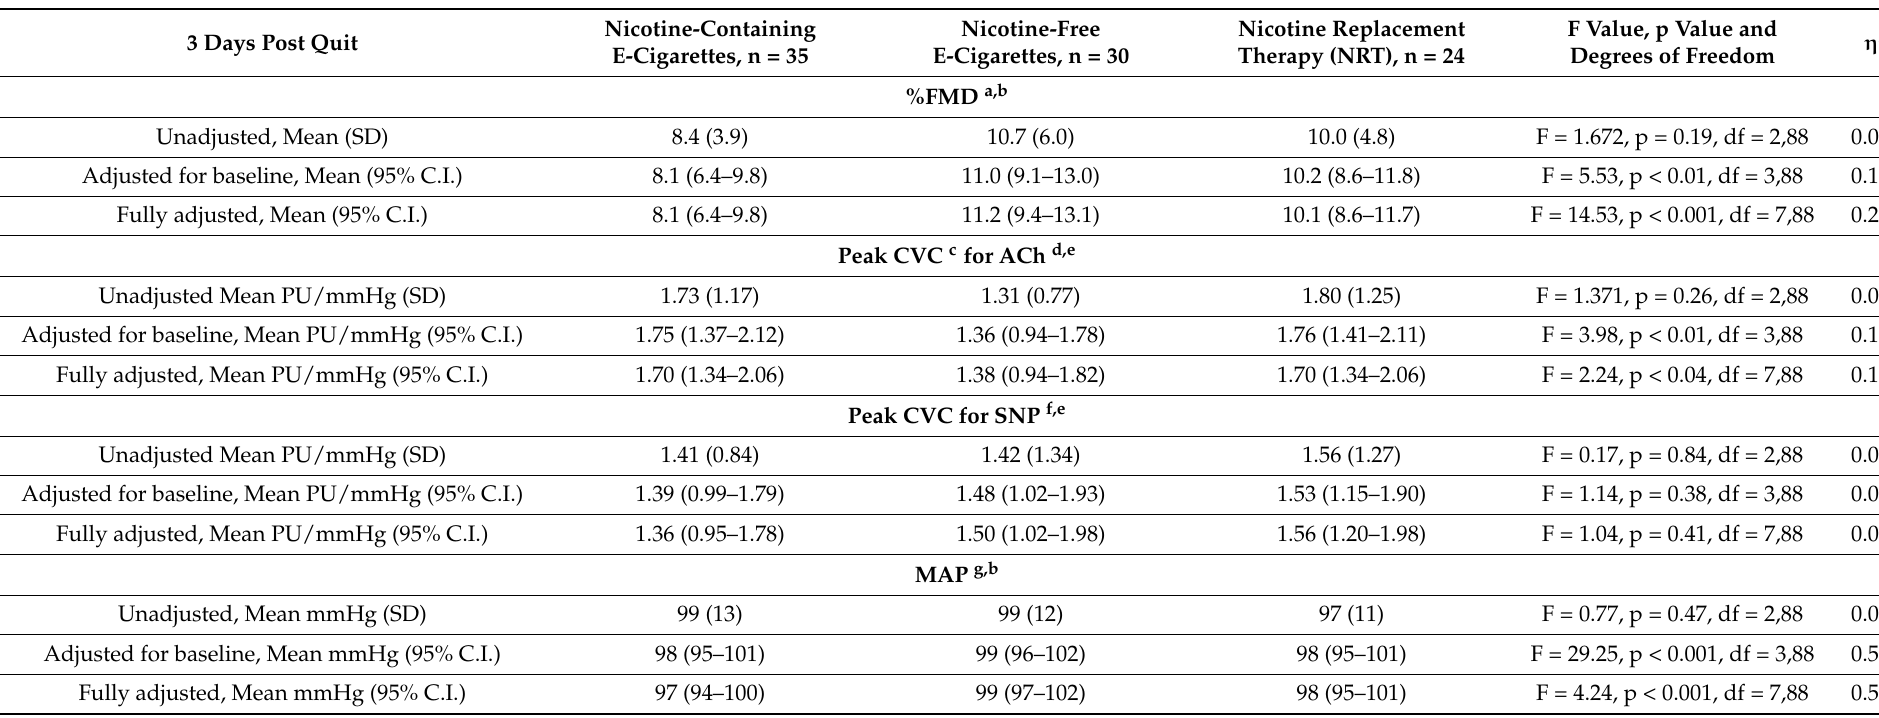
Table 3. Presentation of the results for the General Linear Model for all outcomes at 3 days post quit in subgroup analysis of smokers smoking ≥ 20 cigarettes per day ( Heavy Smokers ). 3 Days Post Quit